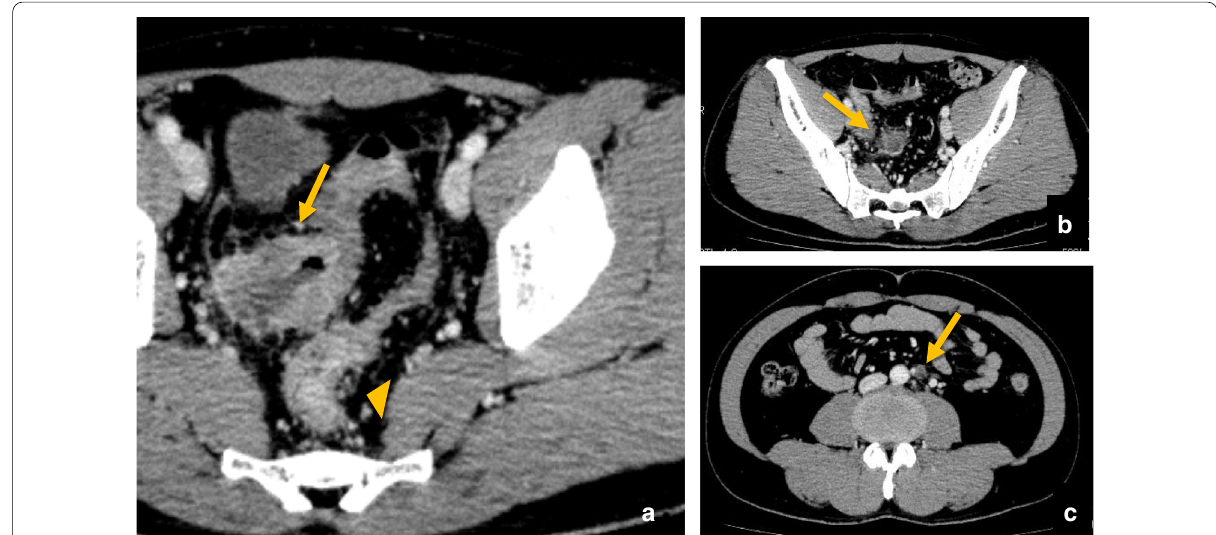
Fig. 1 Computed tomography (CT) scan showed two wall-thickening lesions in the rectum (arrowhead) and sigmoid colon (arrow), with the latter invading the small intestine and abdominal wall ( a ). Lymph nodes were swollen in the sigmoid mesocolon ( b ) and at the roots of the inferior mesenteric artery ( c ). Some of the swollen lymph nodes had sac-like degeneration inside ( b